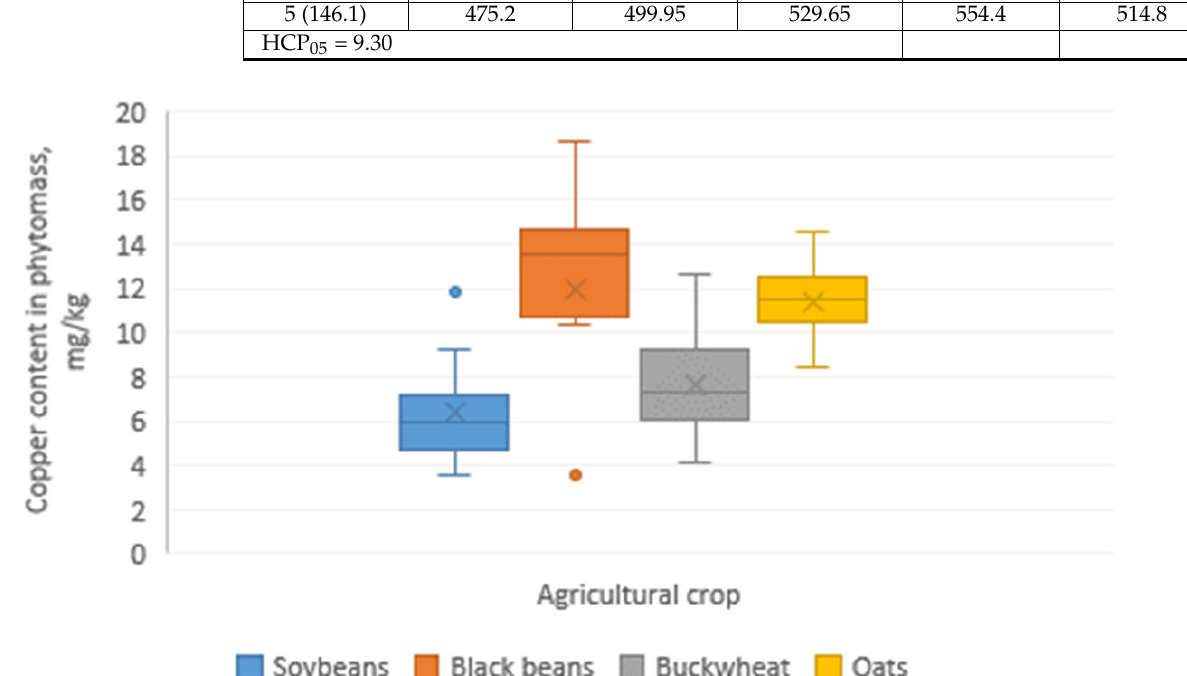
Figure 1. Diagram of copper content in the phytomass of test crops on the variants of the vegetation experiment, depending on the values of the total index of soil contamination.